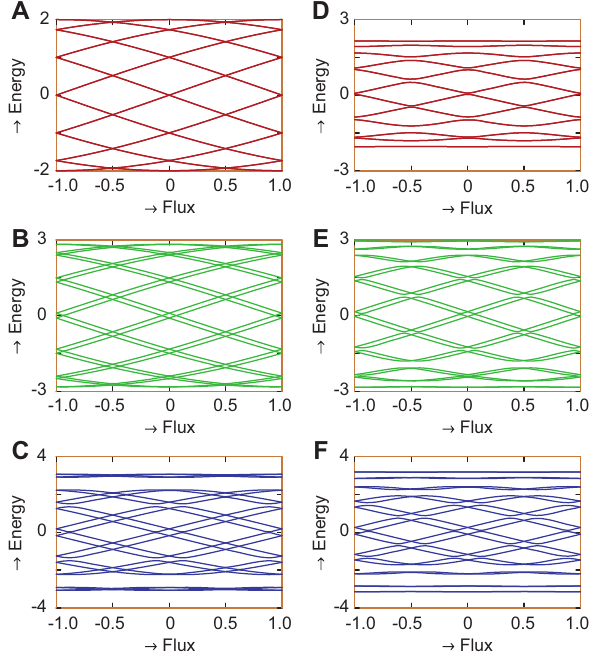
Figure 18 E - φ curves of a 12-site ring, where the fi rst and sec- ond columns correspond to the results for the ordered ( W = 0) and disordered ( W = 1) cases, respectively. The red, green, and blue lines correspond to t respectively.